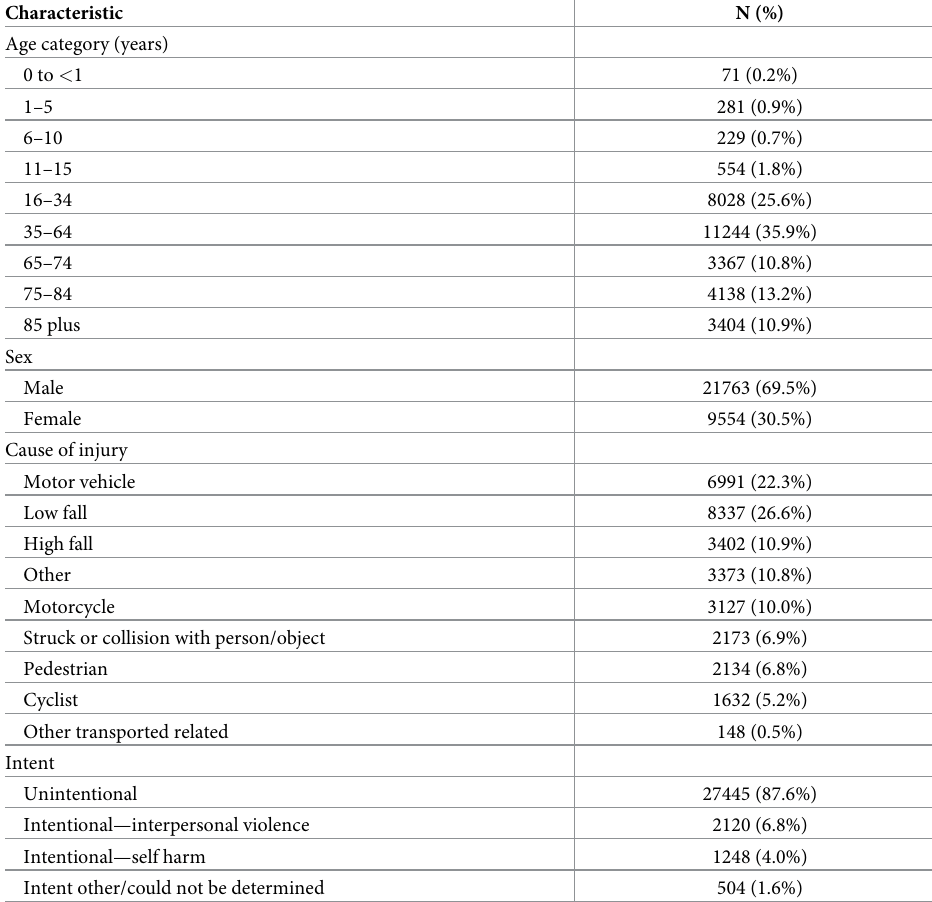
Table 1. Summary of the data used in our analysis (N = 31,317; see also Fig 2).